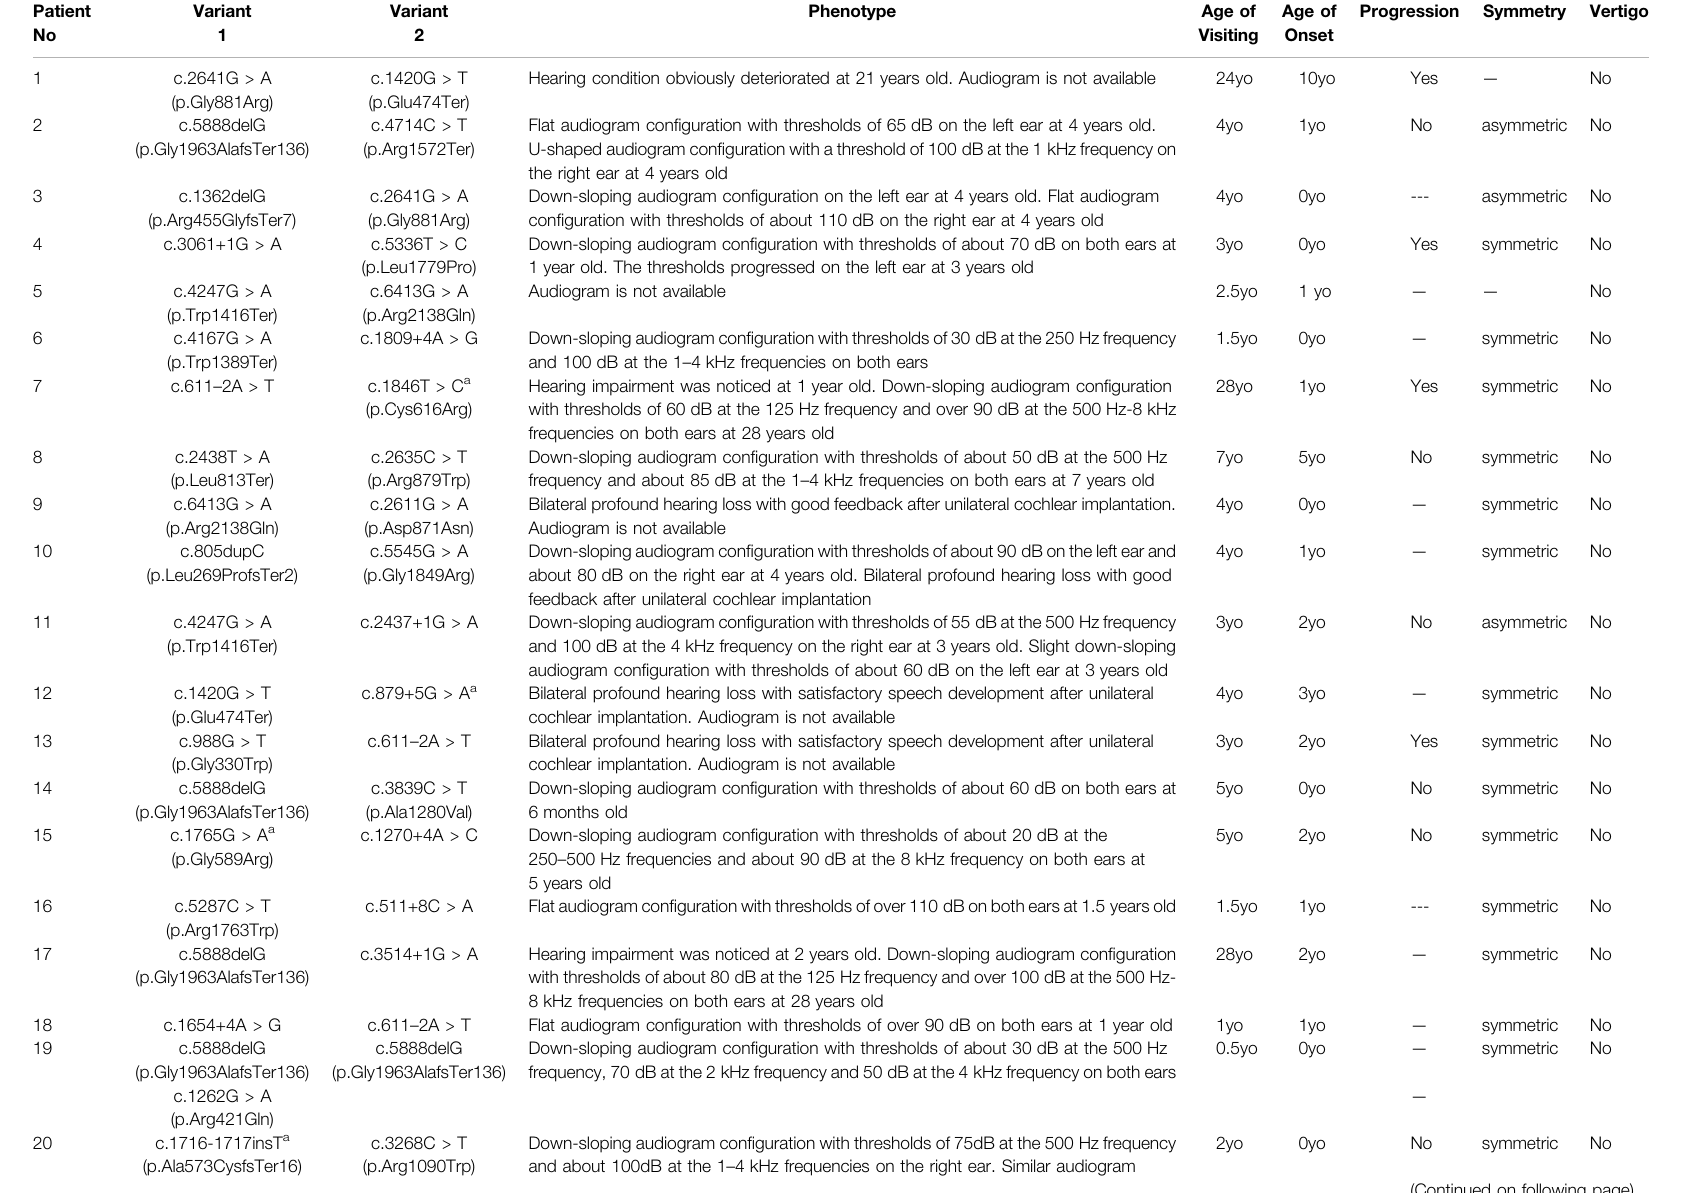
TABLE 2 | Clinical features and LOXHD1 pathogenic variant combinations of affected probands identi fi ed in the present study